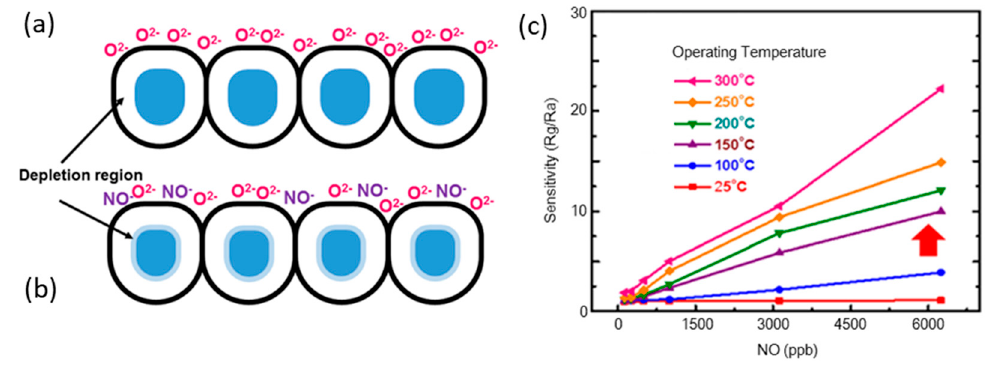
Figure 24. Interactions between the surface of ZnGa 2 O 4 thin film and adsorbed molecules: ( a ) before injection of NO and ( b ) after injection of NO. ( c ) Sensitivity of ZnGa 2 O 4 gas sensor versus different NO gas concentrations at different temperatures from 25 to 300 °C [94].